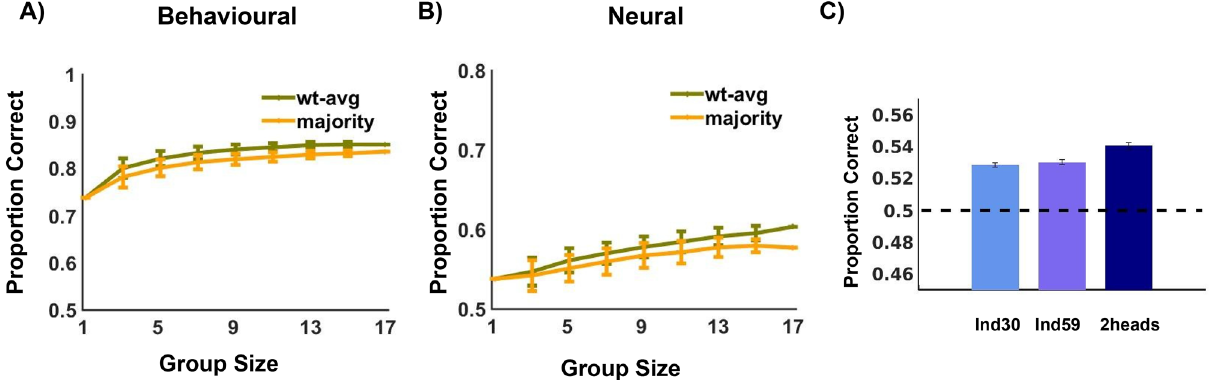
Figure 3. Group Aggregation. ( A , B ) Performance benefits achieved using the commonly used majority pooling algorithm and the weighted average algorithm across group sizes from behavioural ( A ) and neural ( B ) data. The proportion of correct trials is consistently more upon combining the individual decisions using the weighted average rule. Error bars indicate ± SD. ( C ) Control study to check that the the performance benefits achieved are not due to addition of more electrodes but due to multiple brains. The PC increases when doubling the number of heads relative to doubling the number of electrodes. ‘Ind30’ denotes single brain with 30 electrodes, ‘Ind59’ denotes single brain with all 59 electrodes and ‘2heads’ denotes double brain with 30 electrodes each. Error bars denote ±